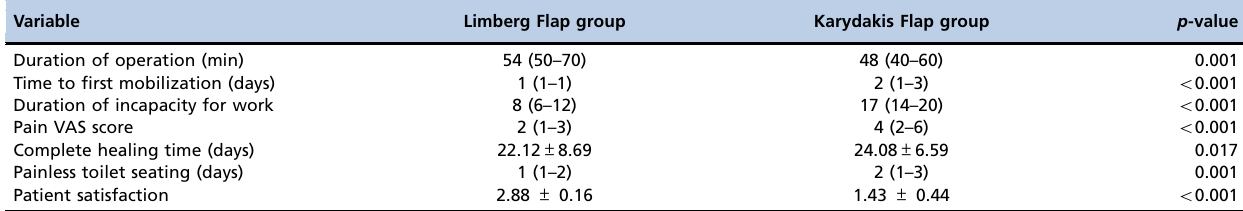
Table 2 - Operative and postoperative